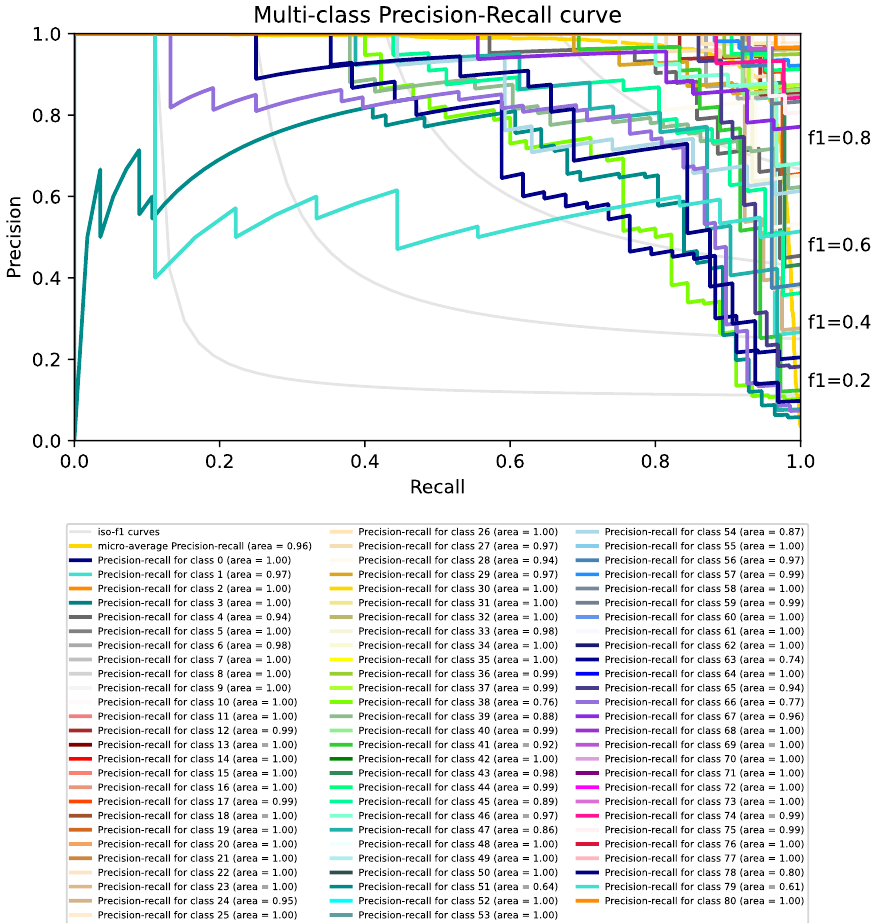
Figure 11. Multi-Class Precision-Recall curve for the tiered model. As observed in the confusion matrix of this tiered model (Table 3), the detection of the oranges and satsumas has been